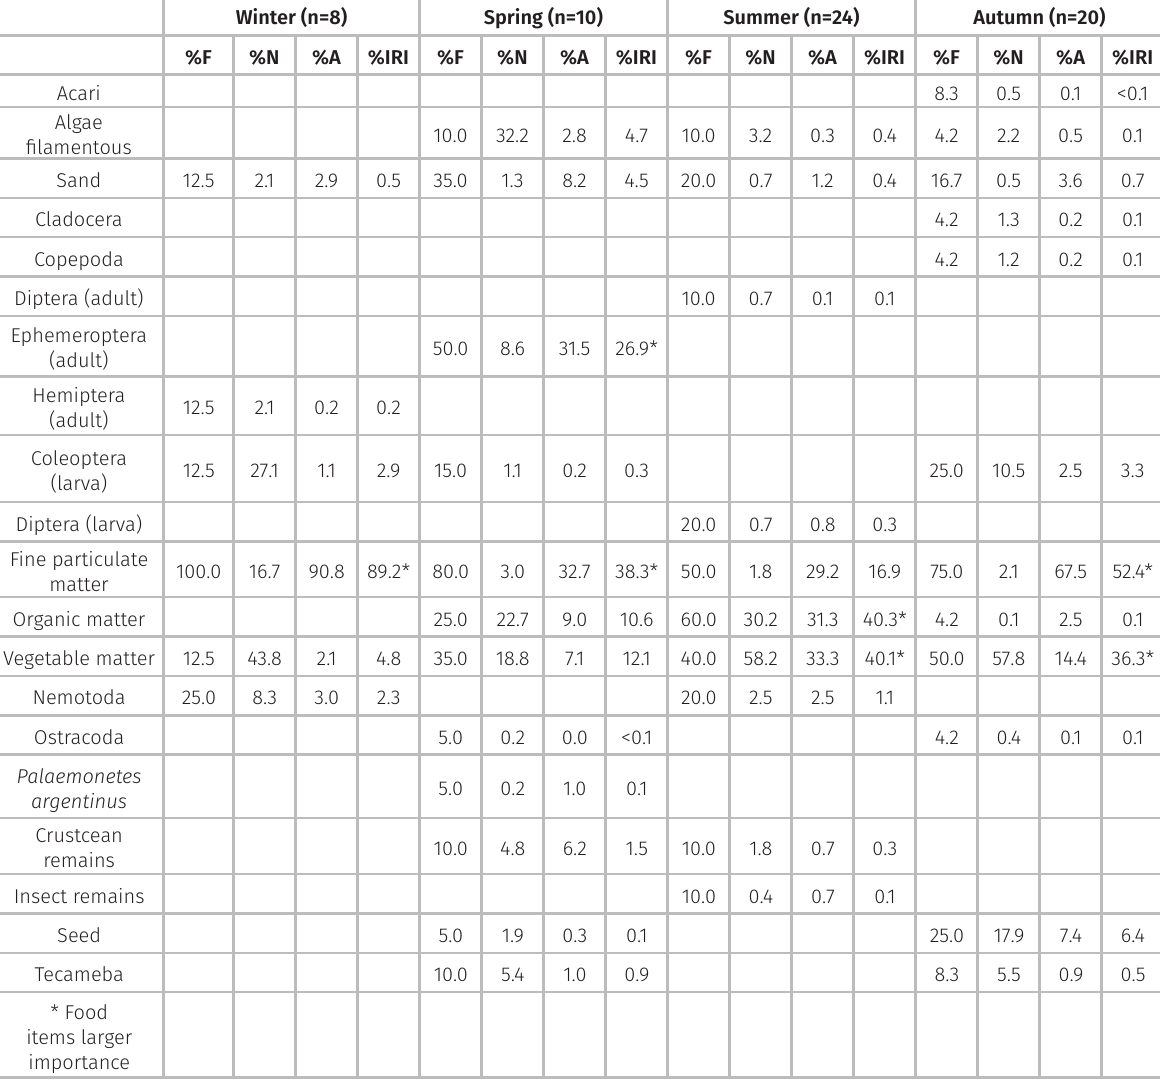
Table II. Frequency of occurrence (%F), numeric frequency (%N), area (%A) and index of relative importance (%IRI) for food items consumed by L. anus collected during the low and high hydrological level in the Chasqueiro reservoir, southern Brazil.